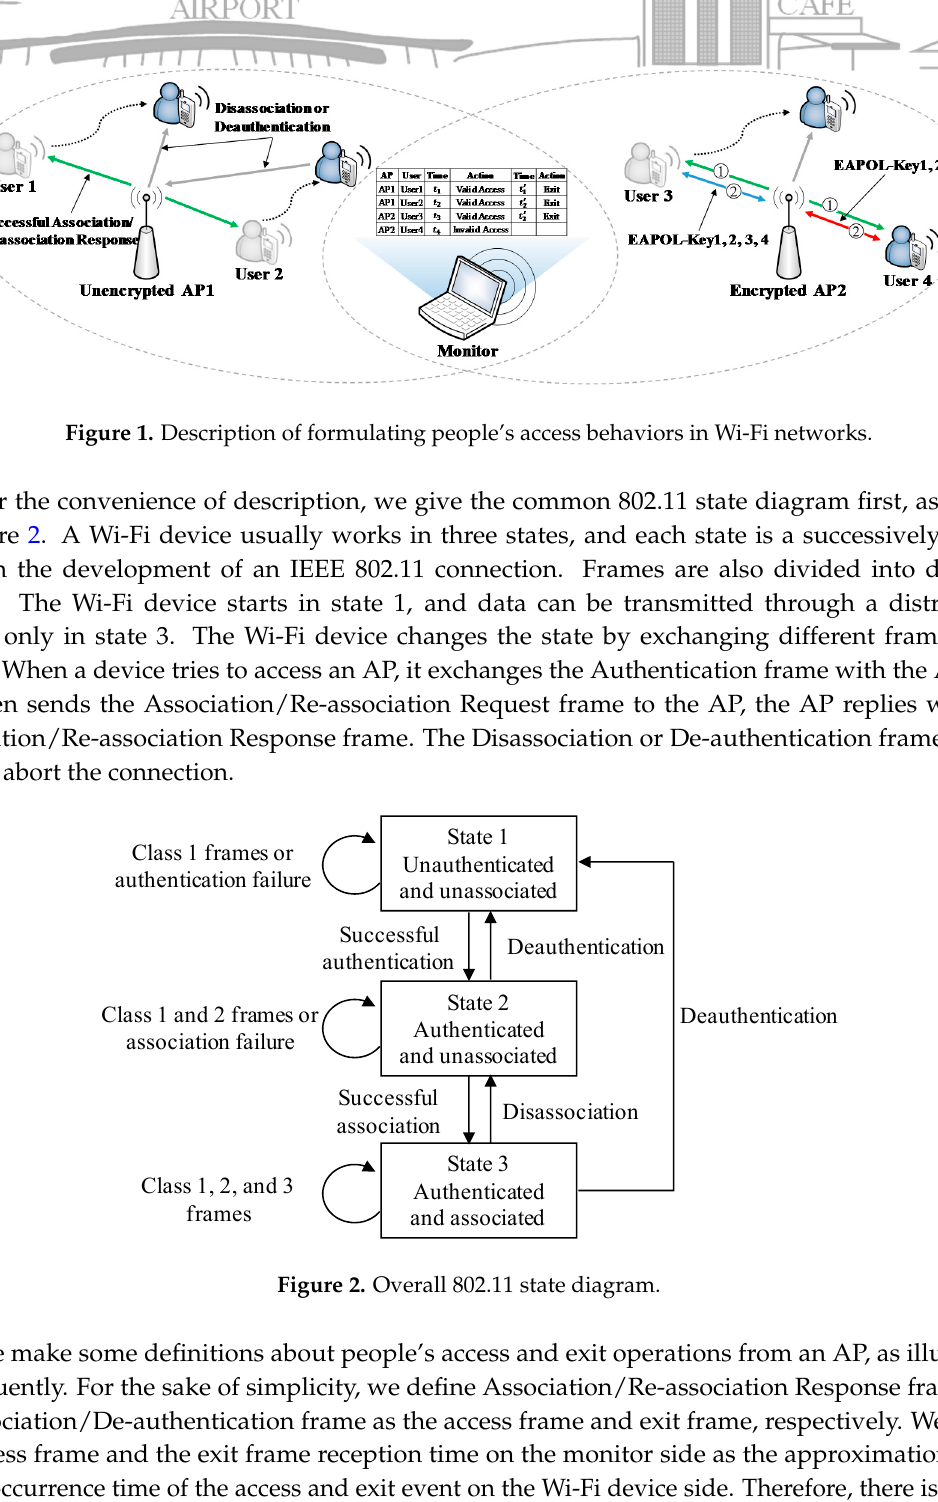
( b ) Figure 3. Procedures of accessing an encrypted AP. ( a ) Access procedures; ( b ) The 4-way handshake.